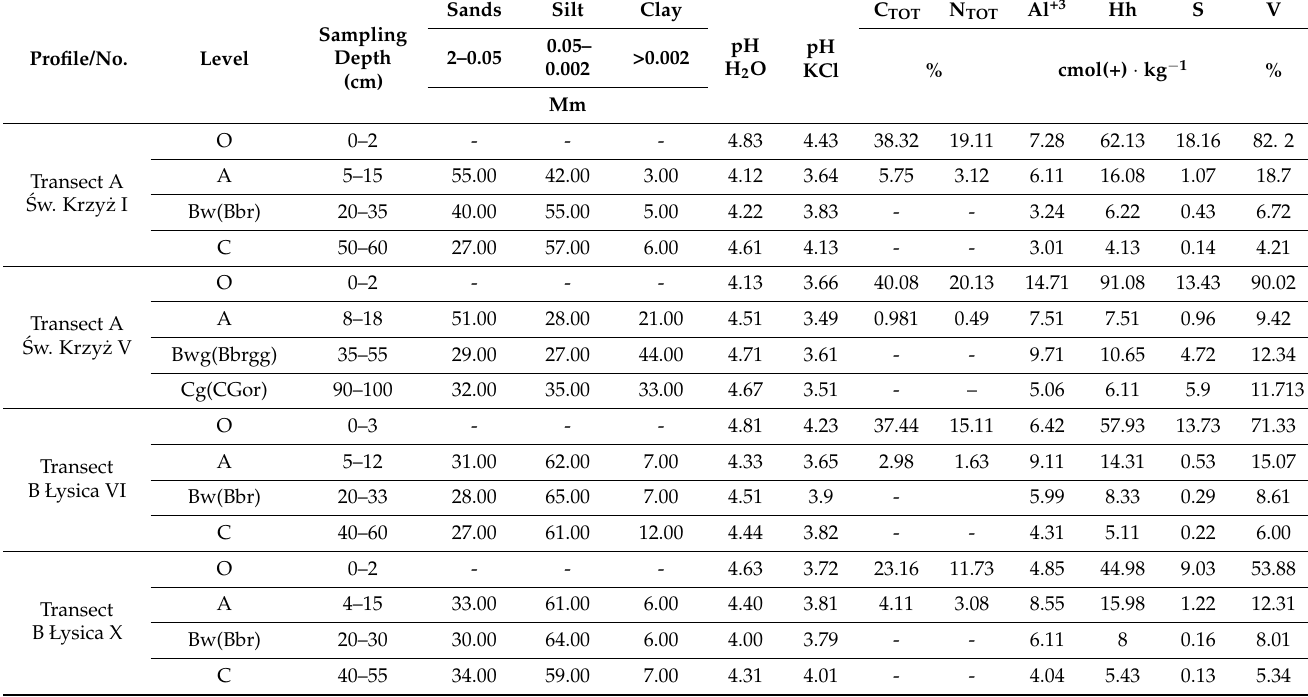
Table 2. Basic soil properties under silver fir growing in ´Swi˛etokrzyski National Park